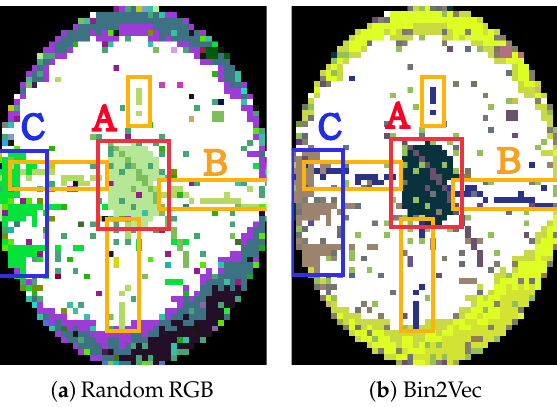
Figure 8. Bin patterns of random RGB and